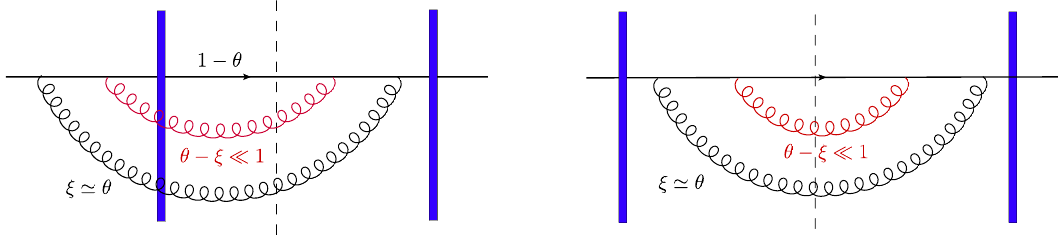
Figure 15 . Diagrams which contribute to the qgg cross-section (3.39) in general, but which do not survive in the eikonal (soft) limit for the gluon with longitudinal momentum fraction θ − ξ (shown in